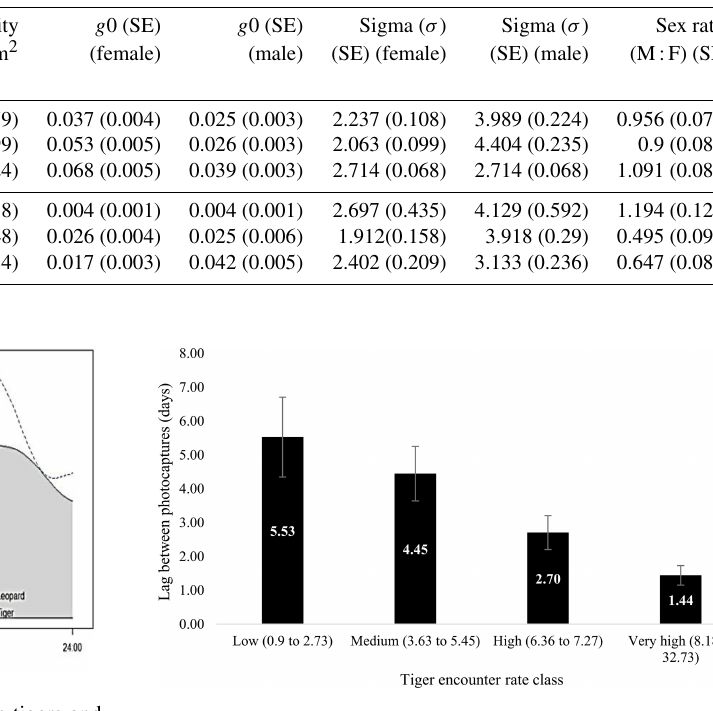
Figure 5. Relationship between average minimum lag between photo capture of a leopard after a tiger has been photographed. Columns represent the average encounter rate of tigers (classified low as lower quantile or least encounter rate and very high as upper quantile or maximum encounter rate of